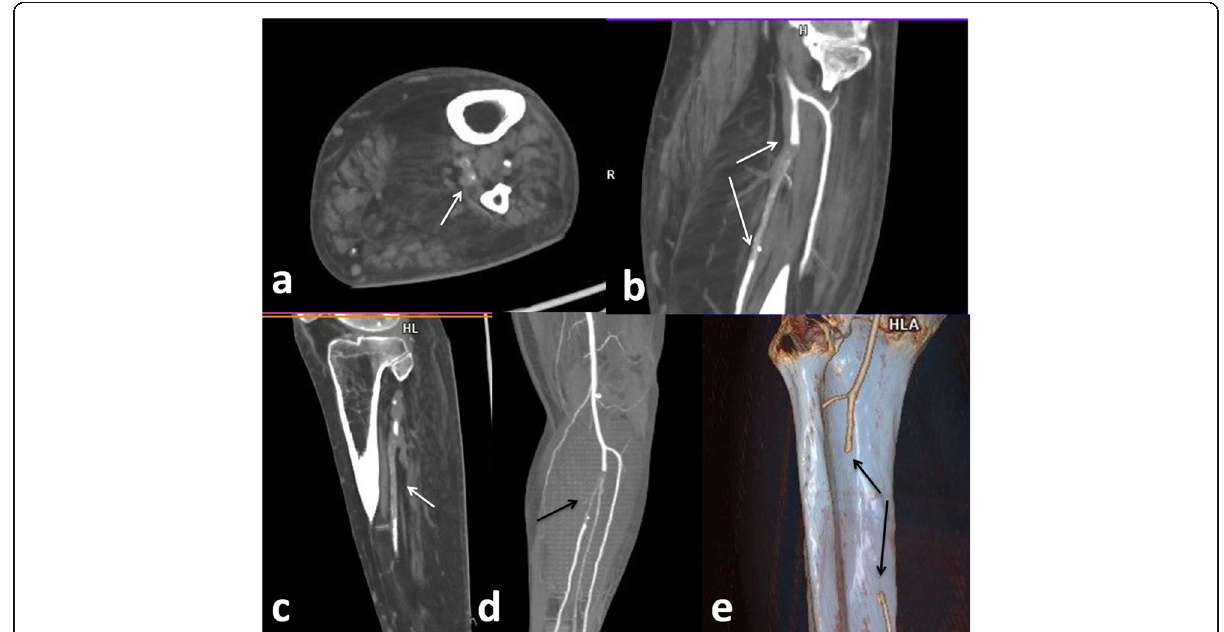
Fig. 12 Female patient 52 years old. Acute thormbus of proximal seep peroneal artery (white arrows in a , b , c ), CTA (black arrow in d ), 3D reconstructed image (filling defect black arrows in e